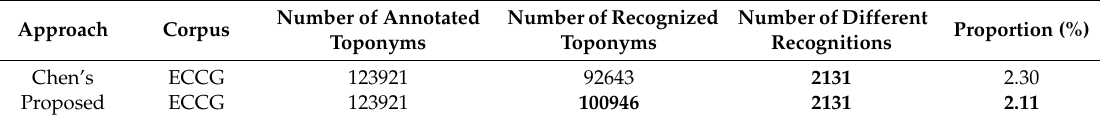
Table 4. Statistics of recognition results of Group